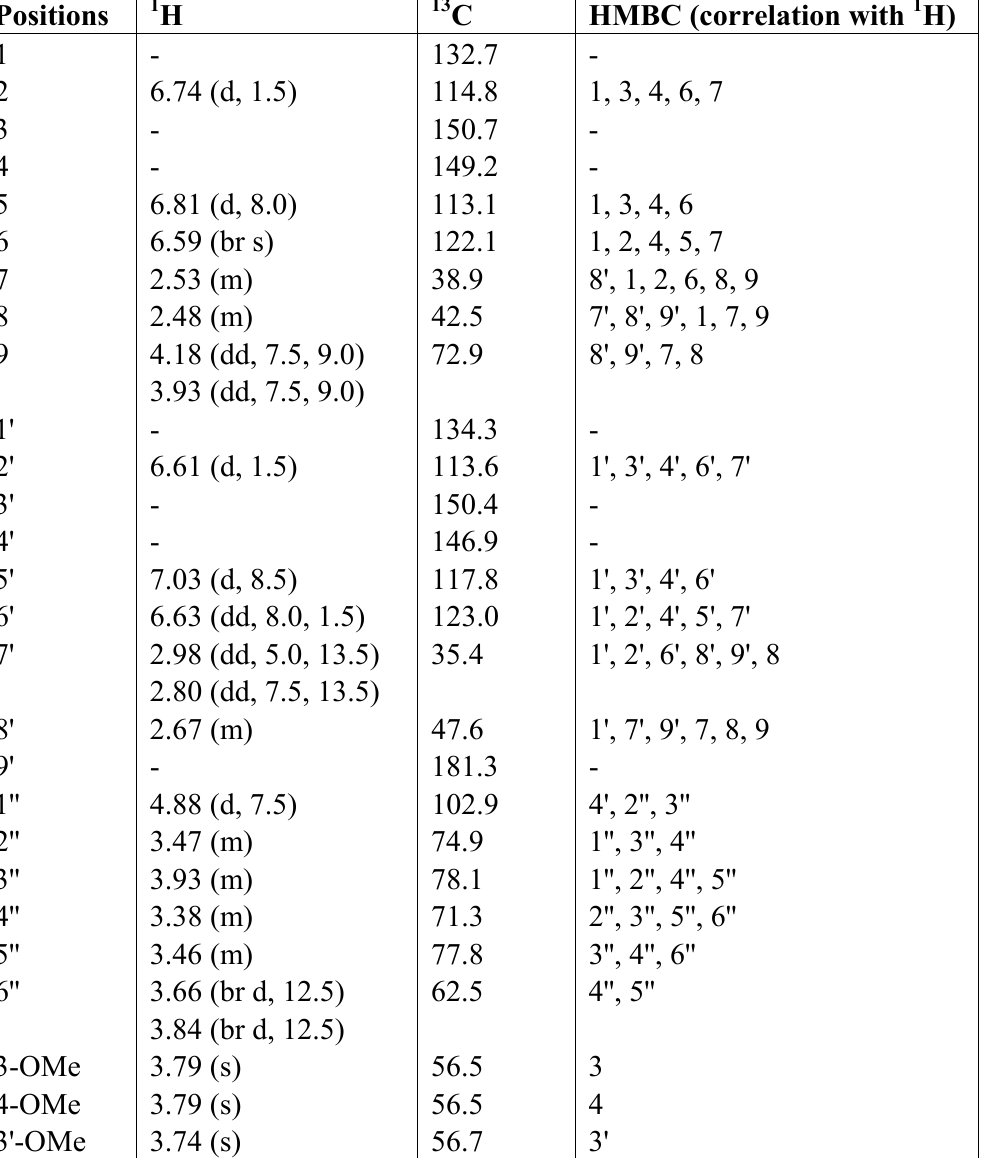
Table 3. 1 H- (500 MHz) and 13 C-NMR (125 MHz) data of 3 (CD ppm) and HMBC